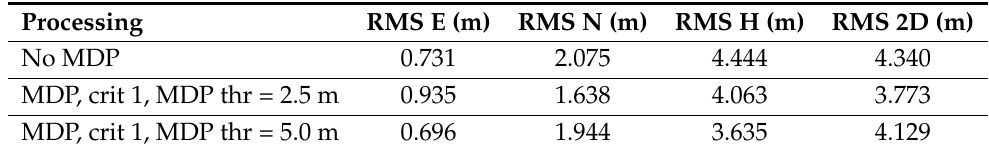
Table 6. RMS obtained for criterion 1, varying static MDP threshold values.